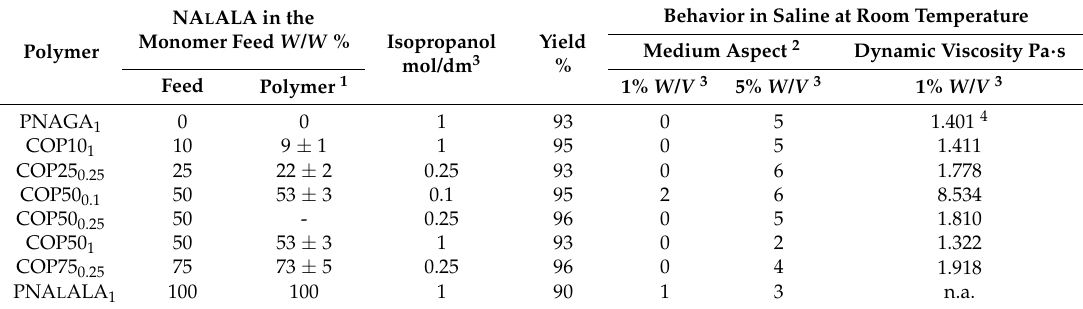
Table 1. PNAGA, PNAGA- co -NA L ALA, and PNA L ALA polymers obtained by radical polymerization in water at 60 ◦ C initiated by 5 × 10 − 4 M K 2 S 2 O 8 in the presence of different amounts of isopropanol transfer